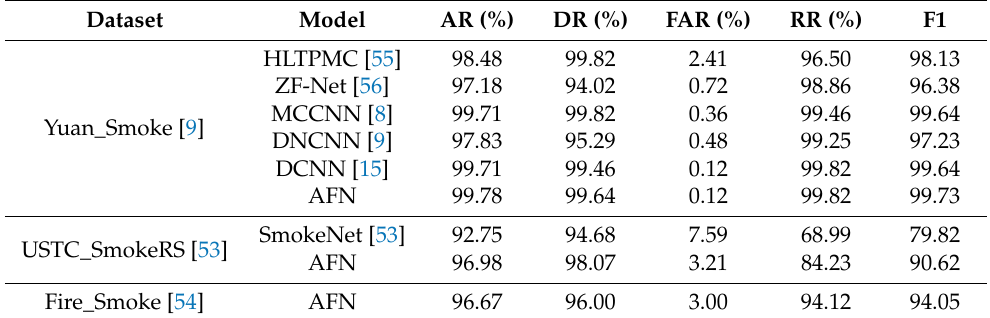
Table 3. Performance comparison with state-of-the-art methods on publicly available smoke datasets.